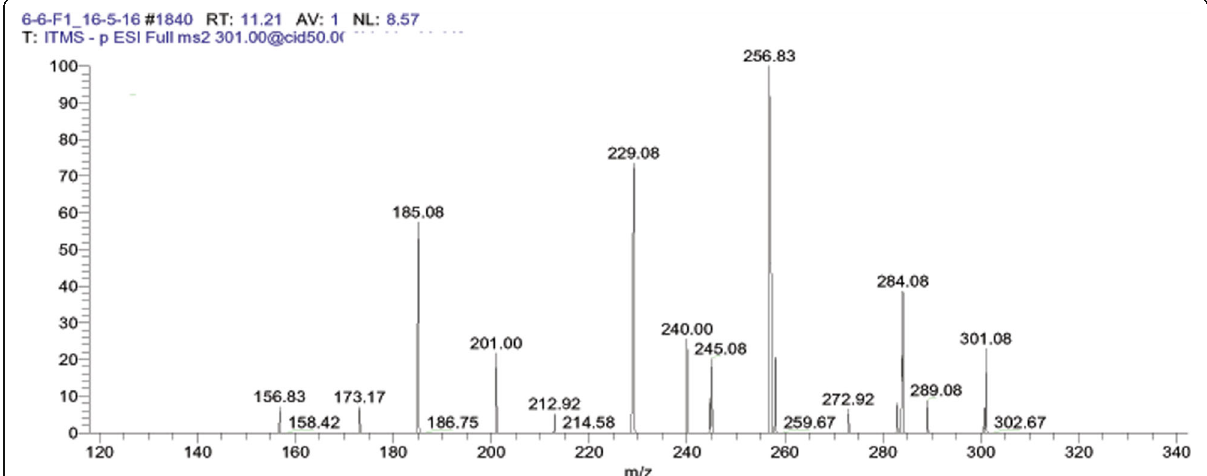
Fig. 1 LC MS/MS Chromatogram of fraction 1 (F1) from aqueous extracts of Glycyrrhiza glabra showing Ellagic